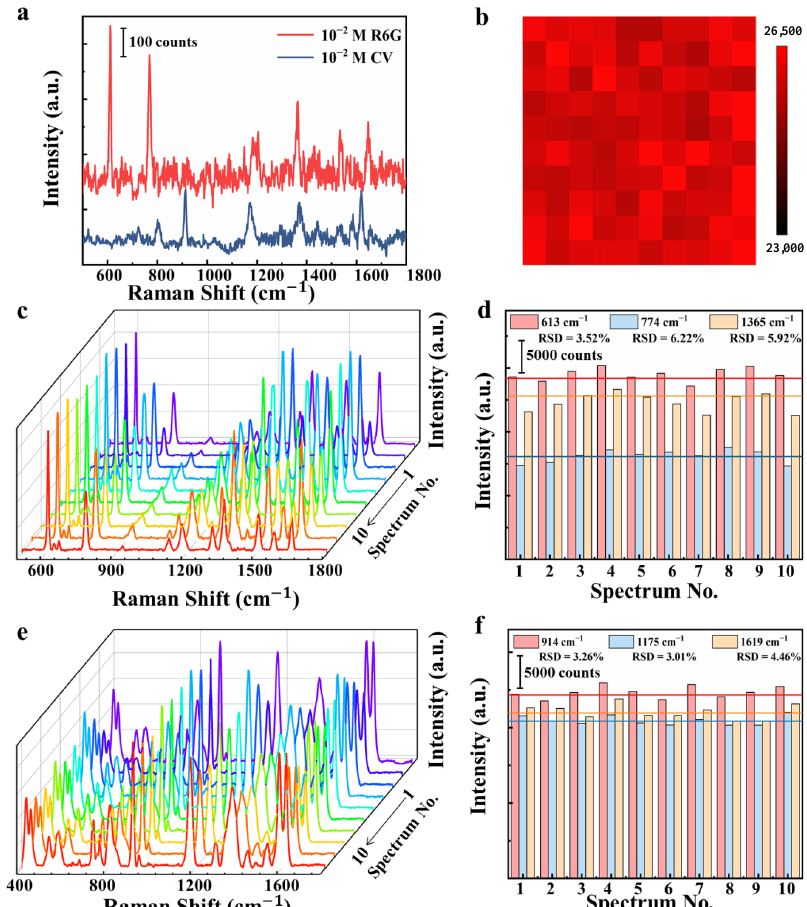
Figure 6. ( a ) Raman spectra of R6G and CV with concentration of 10 − 2 M collected from the SiO 2 substrate. ( b ) Raman mappings at the 613 cm − 1 peak in 20 × 20 µ m 2 area collected from multilayer substrate with four CM–EM units. Raman spectra of ( c ) R6G with a concentration of 10 − 6 M and ( e ) CV with a concentration of 10 − 5 M from 10 di ff erent batches of multilayer substrate with four CM–EM units. Intensity distribution of the peak at ( d ) 613, 774, and 1365 cm − 1 for the R6G with a concentration of 10 − 6 M and ( f ) 914, 1175 and 1619 cm − 1 for the CV with a concentration of 10 − 5 M from 10 di ff erent batches of multilayer substrate with four CM–EM